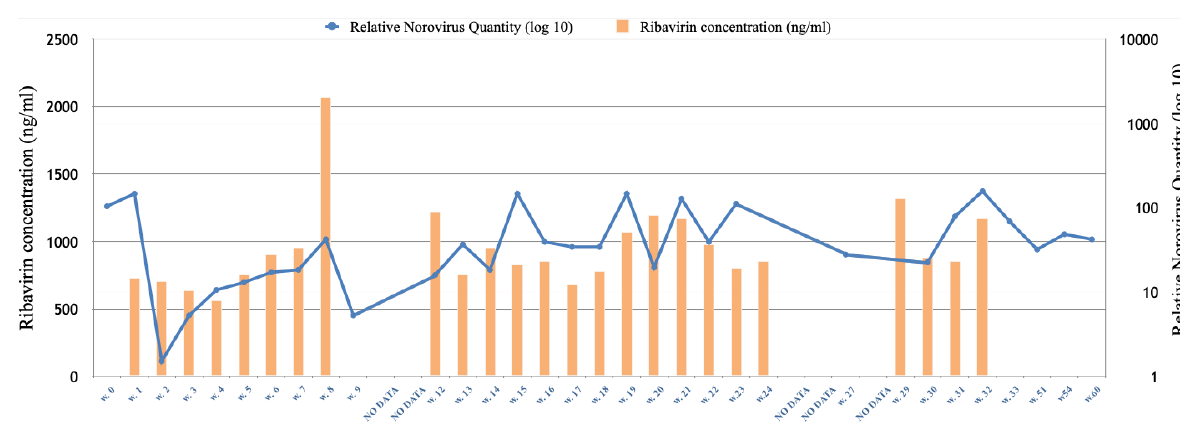
Figure 4. Serum analysis of ribavirin concentration (ng/mL in serum), designated in weeks (w) since started treatment. Treatment start = w. 0. Relative norovirus quantity is expressed as fold change compared to the screened sample with the highest qPCR Ct value (21.5). At some collection times, either fecal or serum sample could not be collected. NO DATA—no fecal sample and/or ribavirin concentration collected due to illness/treatment from other cause.